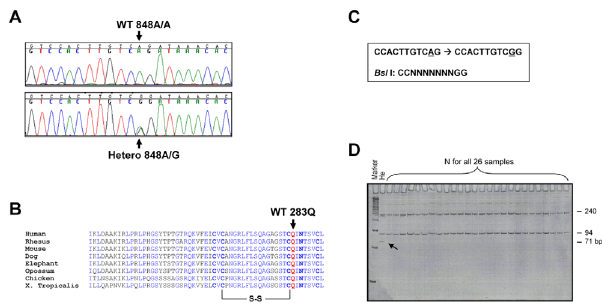
Fig 3. Genotypic analysis of the Exon-8 of the human δ -SG gene. Fig 3 A shows genomic sequences of a wild type sample ( upper panel ) and a sample with 848A/G ( lower panel ). Fig 3 B illustrates that 848A/G results in Q283A in the highly conserved C-terminus of the δ -SG gene among different species. Fig 3 C shows that 848A/G creates a neonate cutting site for Bsl I. Fig 3 D demonstrates differential cutting patterns by Bsl I of normal samples ( N ; double bands of 94 and 240bp) and a sample with 848A/G ( He ; quadruple bands of 23, 71, 94 and 240bp). The cut samples were separated on 12.5% polyacrylamide gel and the gels were stained by SYBR-green.